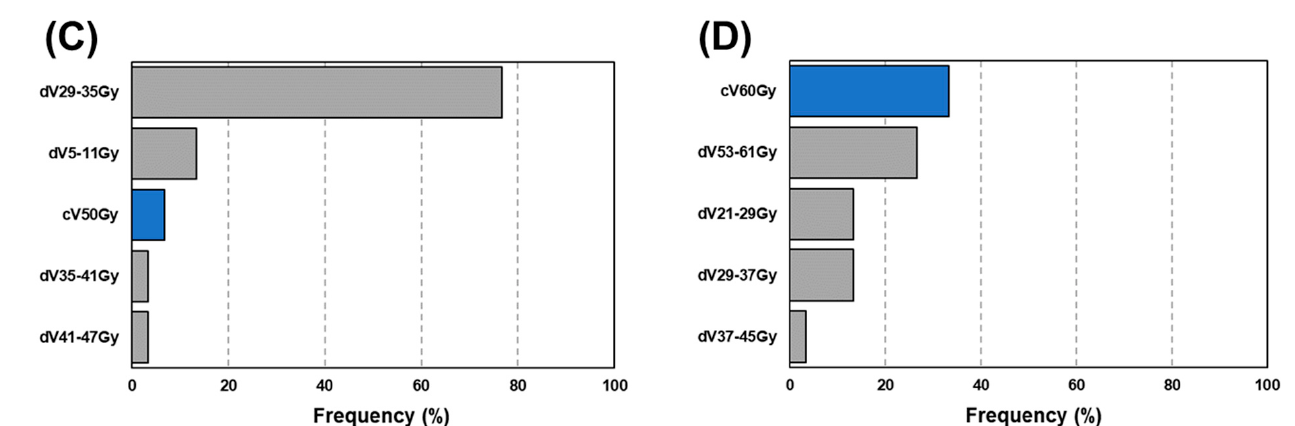
Figure 6. Frequency of features giving the highest coefficient in the developed model integrating cDVH and dDVH features with dose bin = 2 Gy ( A ), 4 Gy ( B ), 6 Gy ( C ), and 8 Gy ( D ). Abbreviations: cDVH = cumulative dose − volume histogram; dDVH = differential dose − volume histogram.